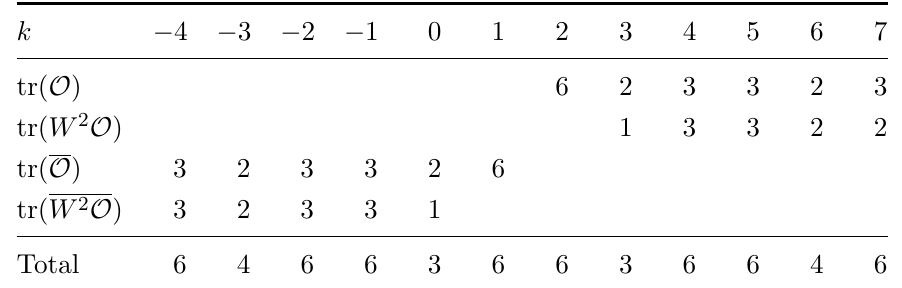
Table 1 . Counting of operators in the field theory dual to S 5 graded by k . Note that the number of tr( W α W α O ) operators, except for the case of k = 0 , 1 , 2 , is the same as the number of tr( O ) operators after a shift of k by